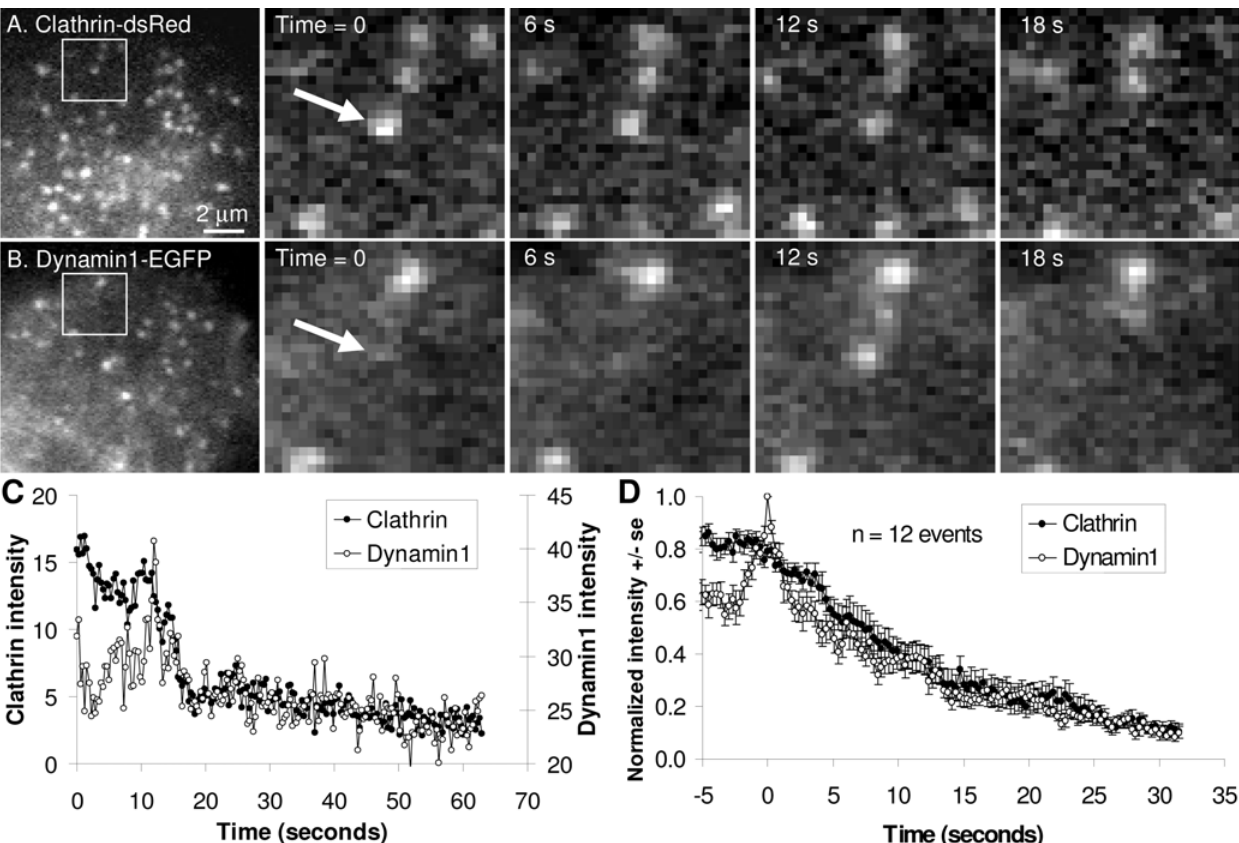
Figure 3. Increase in dynamin1 intensity at sites of clathrin-mediated endocytosis in PC12 cells. PC12 cells co-transfected with clathrin- dsRed (A) and dynamin1-EGFP (B) were imaged by live-cell TIR-FM. Frames with time-stamps represent magnifications of regions identified directly to the left. Quantification of the spot marker by the arrow (C) shows burst of dynamin1 fluorescence just prior to endocytosis. Additionally, clathrin fluorescence remains roughly constant prior to internalization. Quantification of 12 such events is shown is (D).